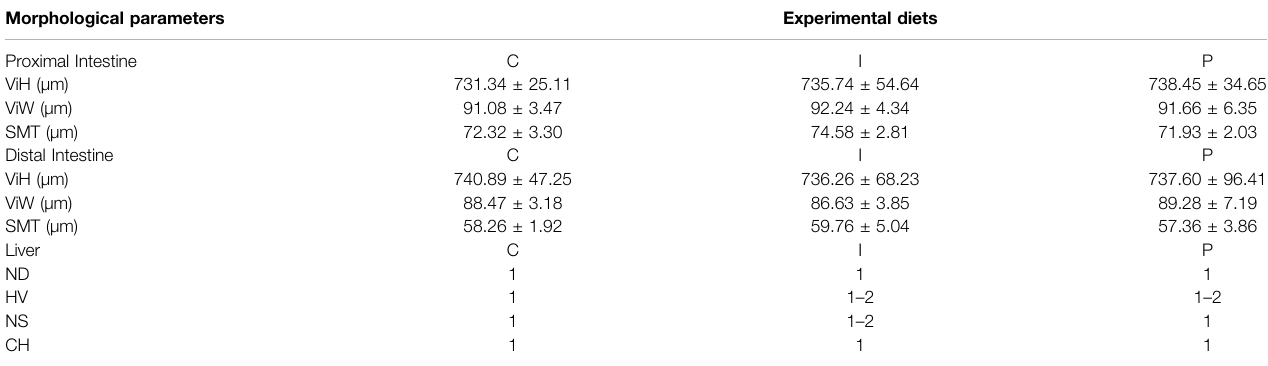
TABLE3| Histologicalchangesinproximalanddistalintestineandintheliverofrainbowtroutfeddifferentexperimentaldiets.Proximalanddistalintestinedataareshownas mean ± standard error. Liver data are expressed as a grading scale (1 = not observed/few, 2 = medium, 3 = severe) ( n = 4). ViH, villi height; ViW, villi width; SMT, submucosal layer thickness; ND, nuclear displacement; HV, hepatocytes vacuolization; NS, irregular nuclei shapes; CH, cellular hypertrophy. C, control diet; I, insect meal diet; P, poultry by-products meal diet.